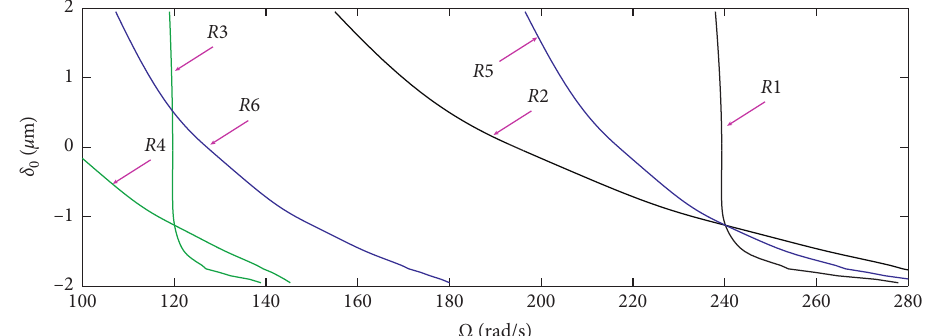
Figure 15: Prediction of the locations of primary resonances (black lines), superharmonic resonances (green lines), and combination resonances (blue lines) from equation